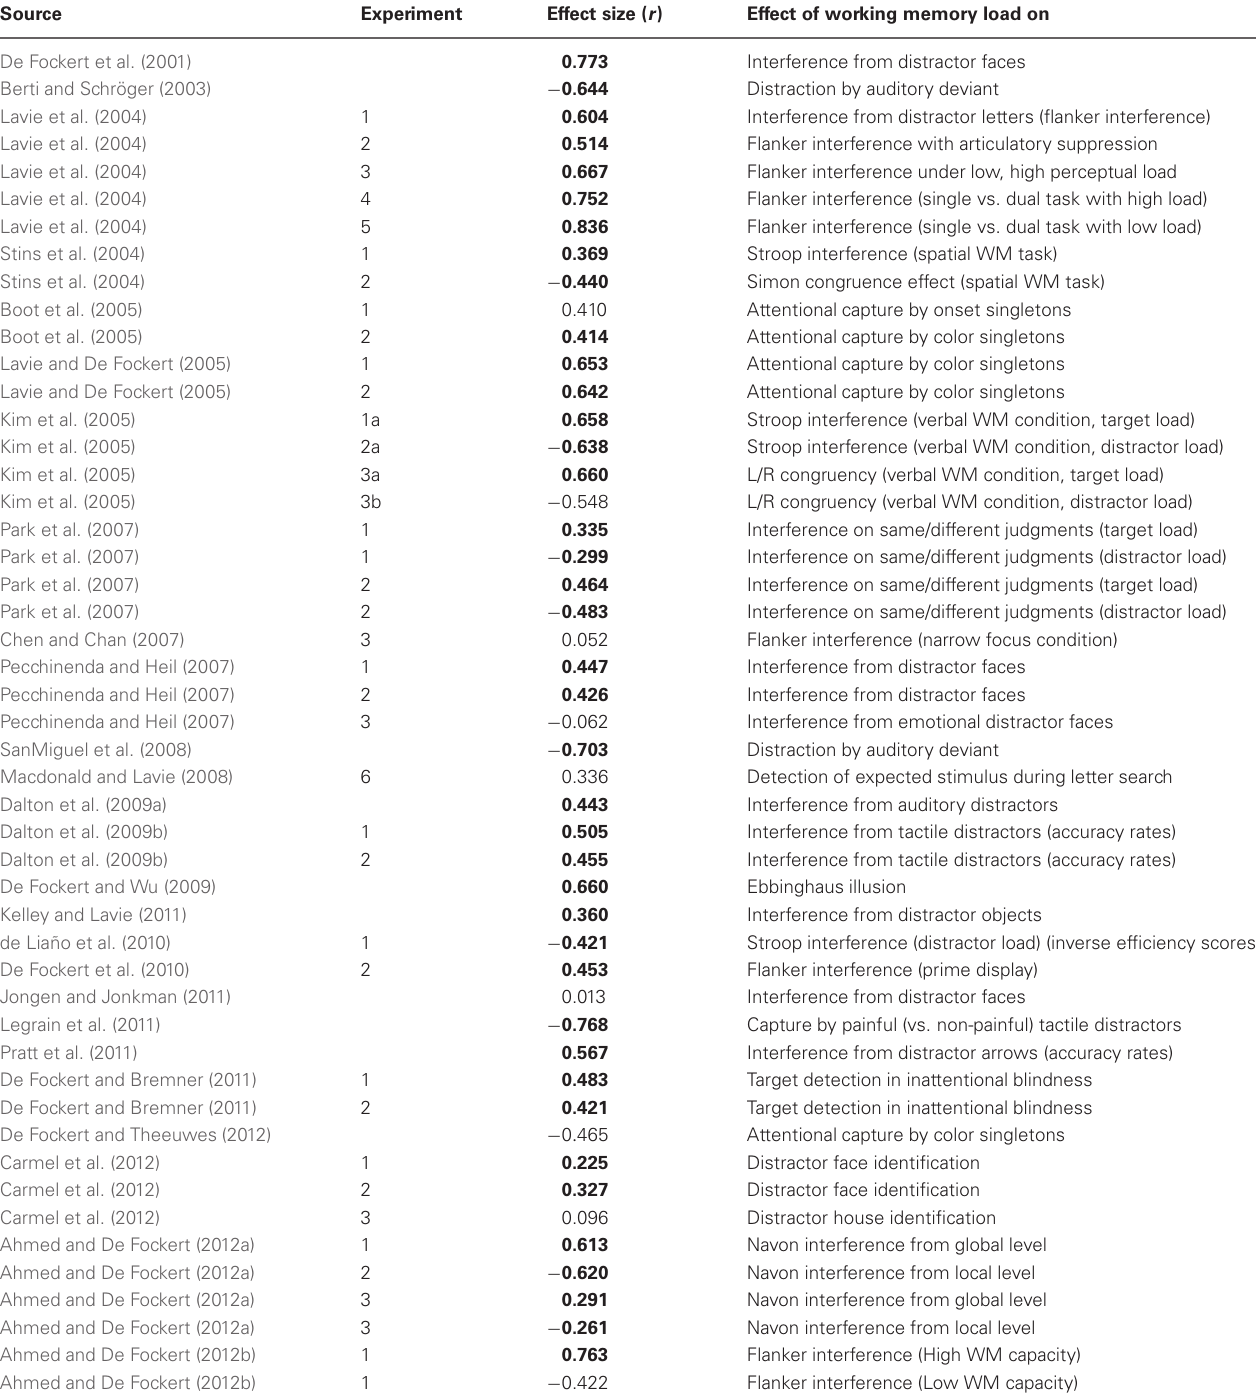
Table 1 | Effect sizes ( r ) for the effect of working memory (WM) load (unless stated otherwise) on distractor processing (reaction time effects, unless stated